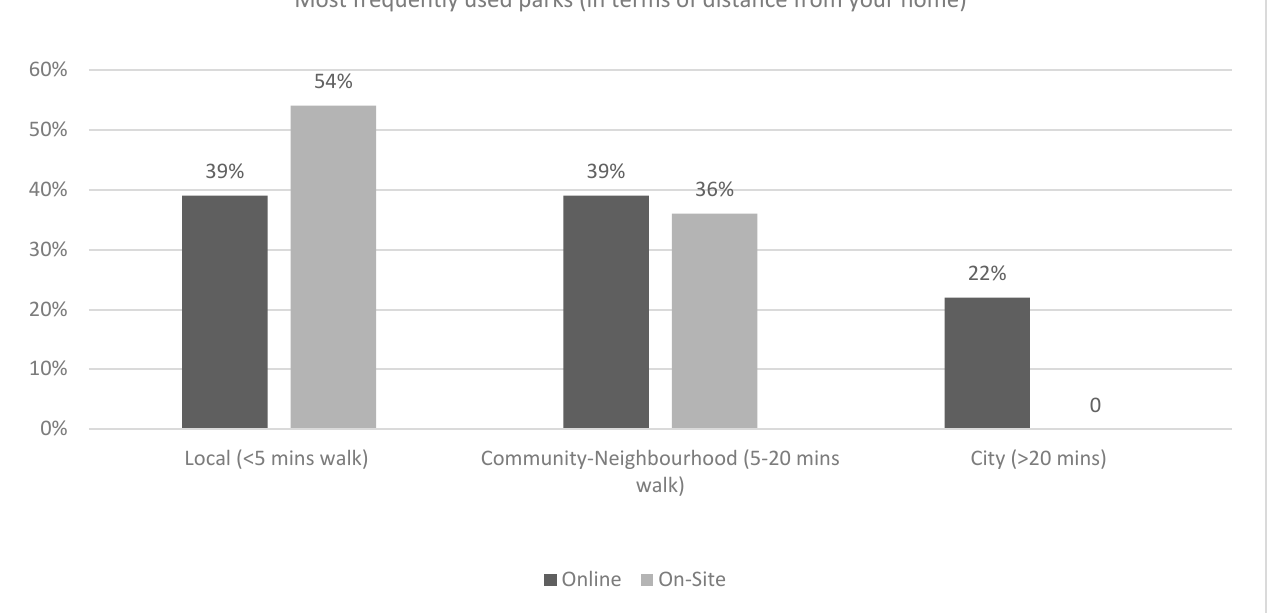
Figure 4. Frequency of park use defined by distance.